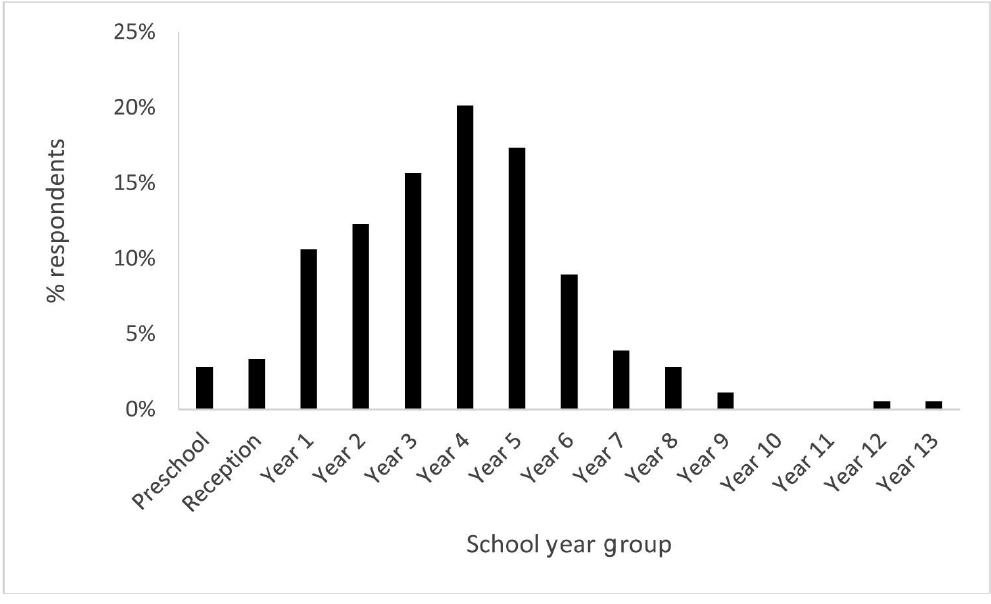
Figure 6: School year groups of 179 children attending Science Hunters public events at Lancashire Science Festival (2017) and Lakeland Wildlife Oasis (2018), at which demographic data were collected from a high proportion (84 per cent) of attending children